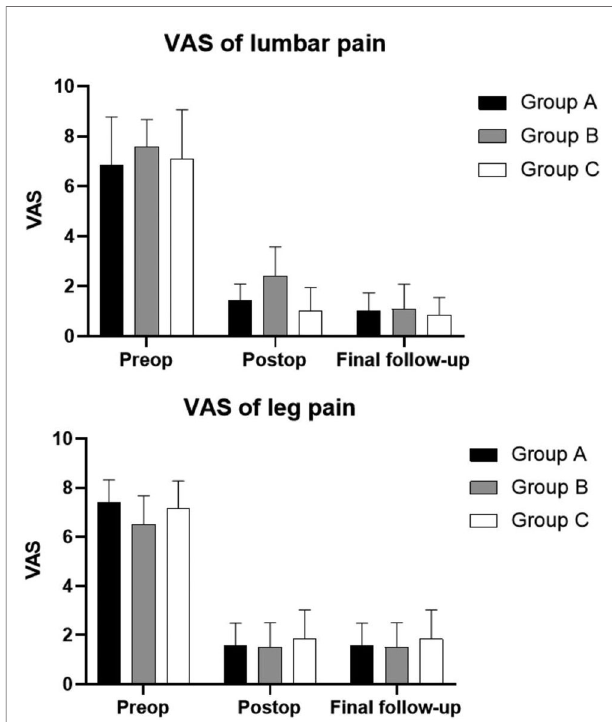
FIGURE 4 | Mean values and standard errors of visual analog scores (VAS) in three groups. ( A ) VAS of lumbar pain in three groups. ( B ) VAS of leg pain in three groups. Abbreviations: Preop, preoperative; postop, postoperative; VAS, visual analog score.